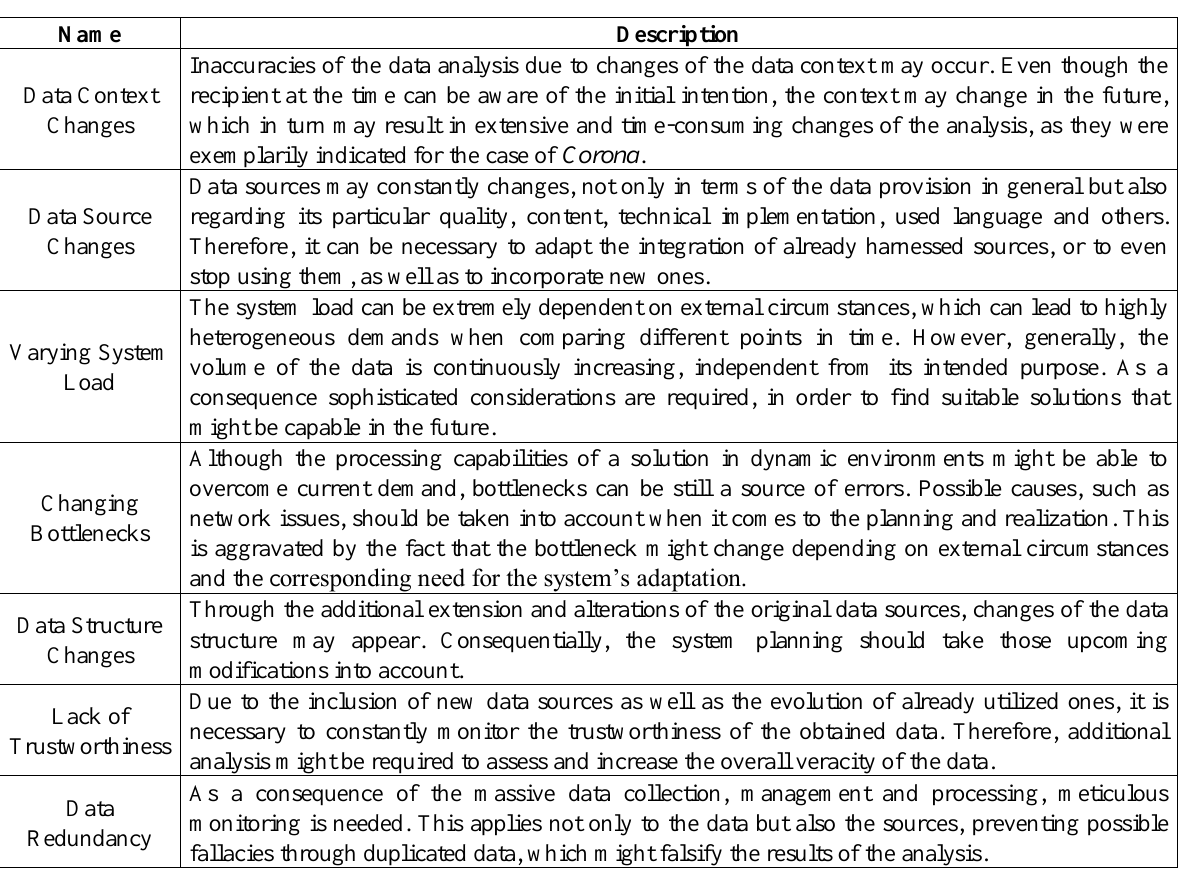
Table 5. Implications of dynamic business environments on